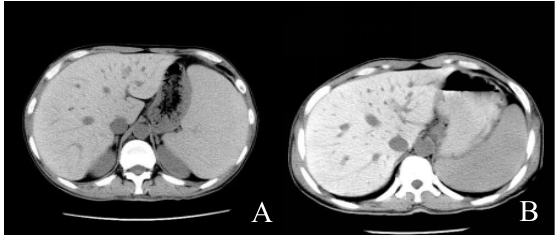
Figure 1. CT showed that the density of liver was increased, manifested as "white liver". A and B is the different cases which CT values were about 87 HU and 116HU, respectively. Simultaneous splenomegaly.